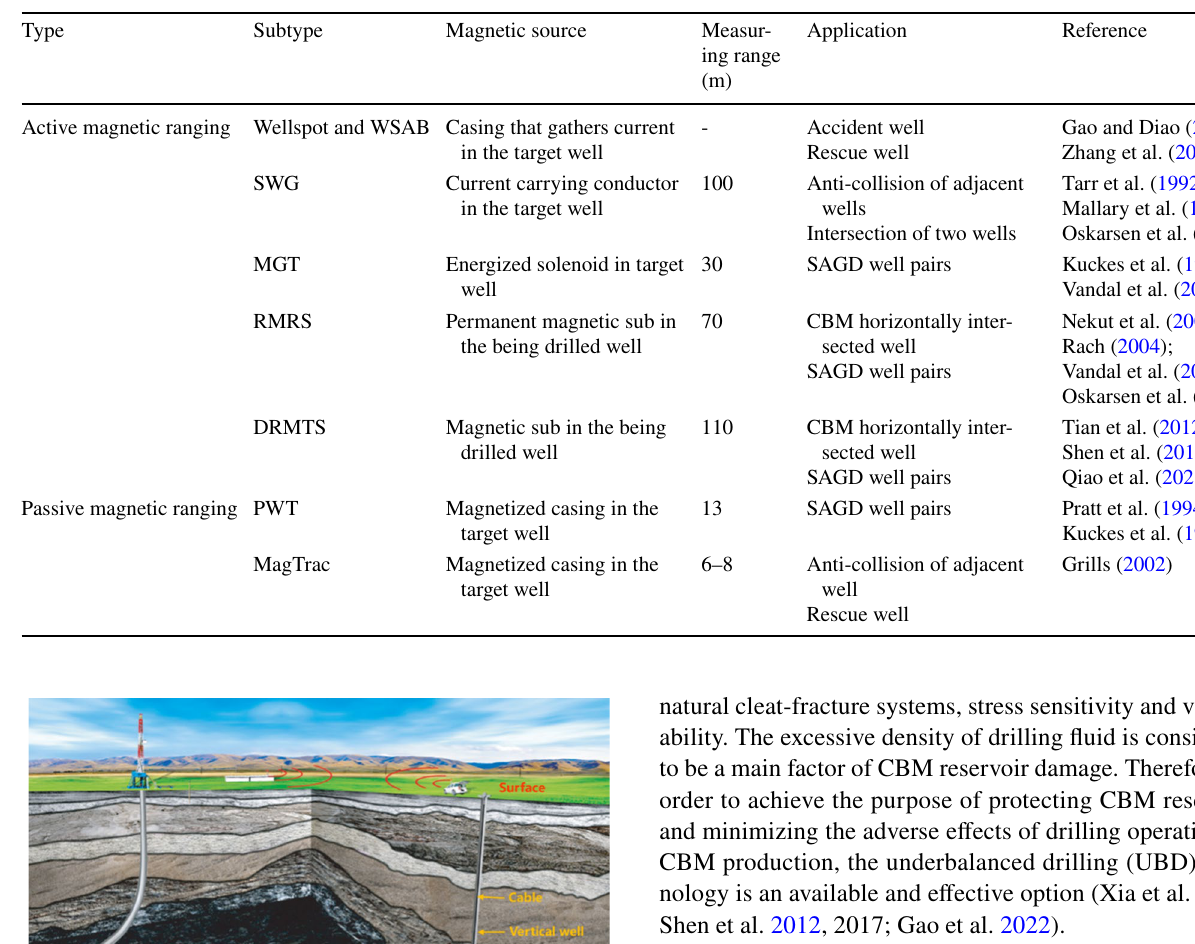
Table 5 Different magnetic ranging technologies